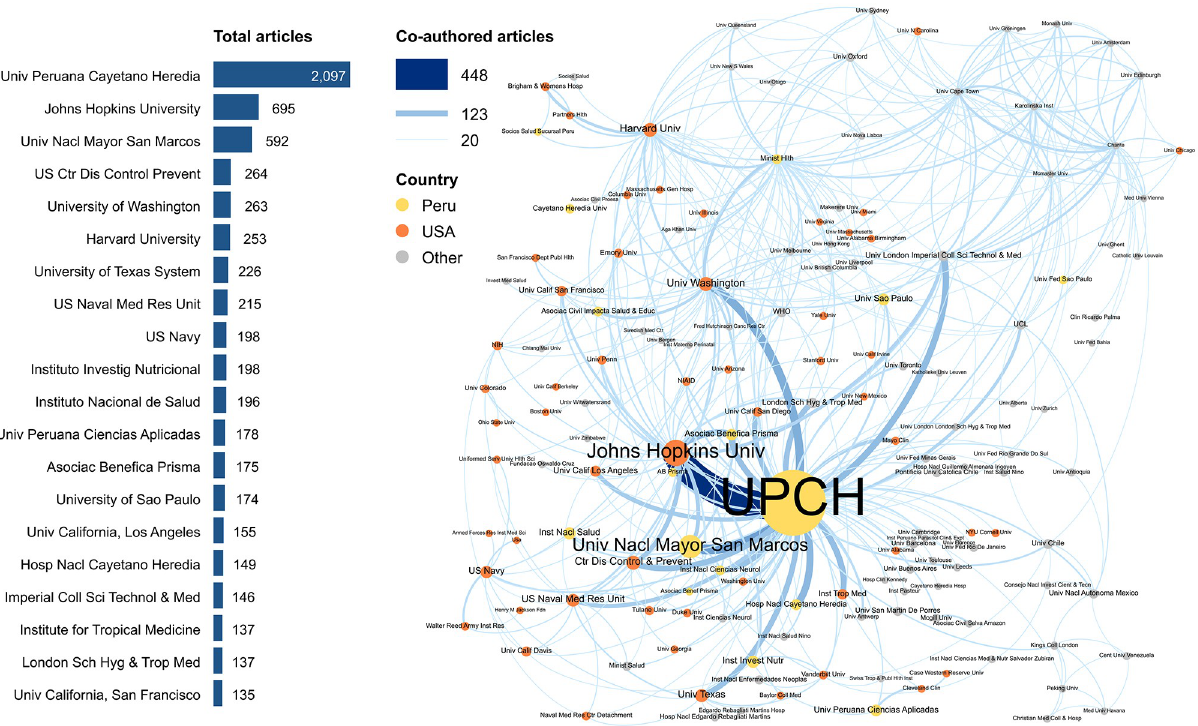
Fig 2. Number of publications per institution and the institutional co-authorship network. Bars indicate the number of publications per institution for the 20 most productive institutions. In the network graphic, circles represent institutions, circle size indicates the institution’s publication count, and circle color indicates whether the institution is located in Peru, the US, or another country. Line thickness and color indicates the number of co- authored publications by authors affiliated with the connected institutions.